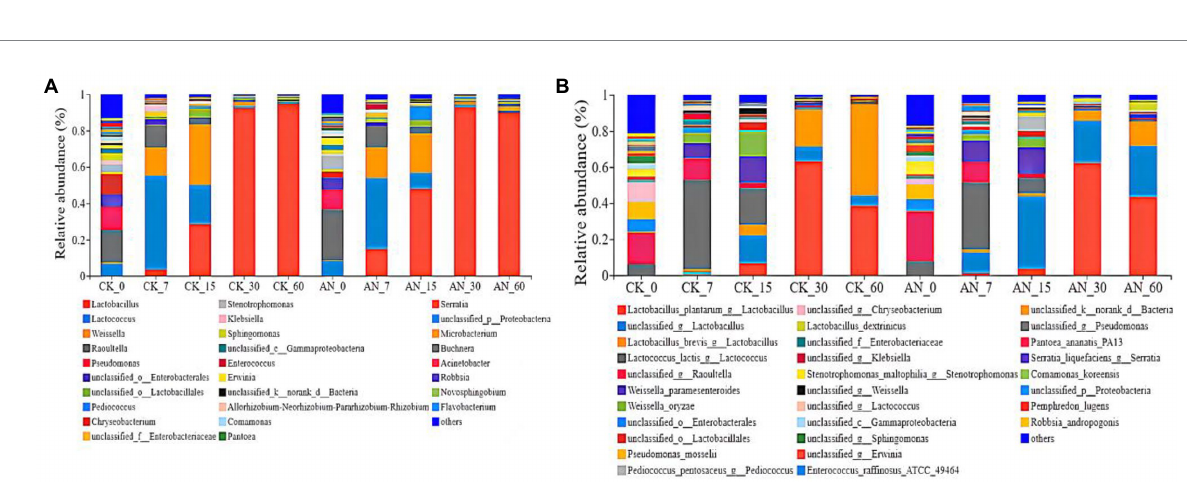
FIGURE 7 Relative abundances of ratooning sorghum silage bacterial based on genus (A) and species (B) . CK, control; AN, with A. niger